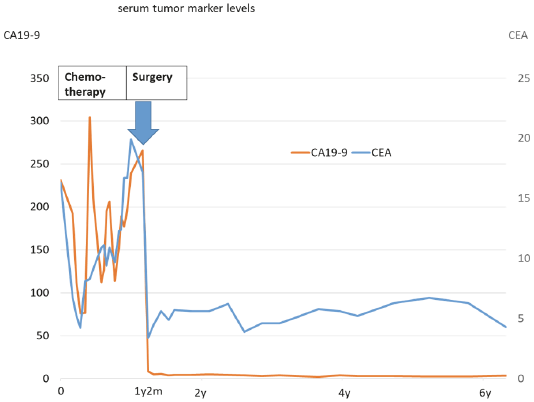
Figure 4: Serum tumor marker concentrations. Serum concen- trations of carbohydrate antigen 19-9 (CA19-9; orange line) and carcinoembryonic antigen (CEA; blue line) were high during chemotherapy but normalized dramatically after surgery, with no significant increase detected to